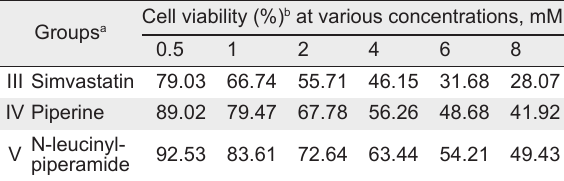
Table 2. Effect of antihyperlipidemic compounds on cell cytotoxicity